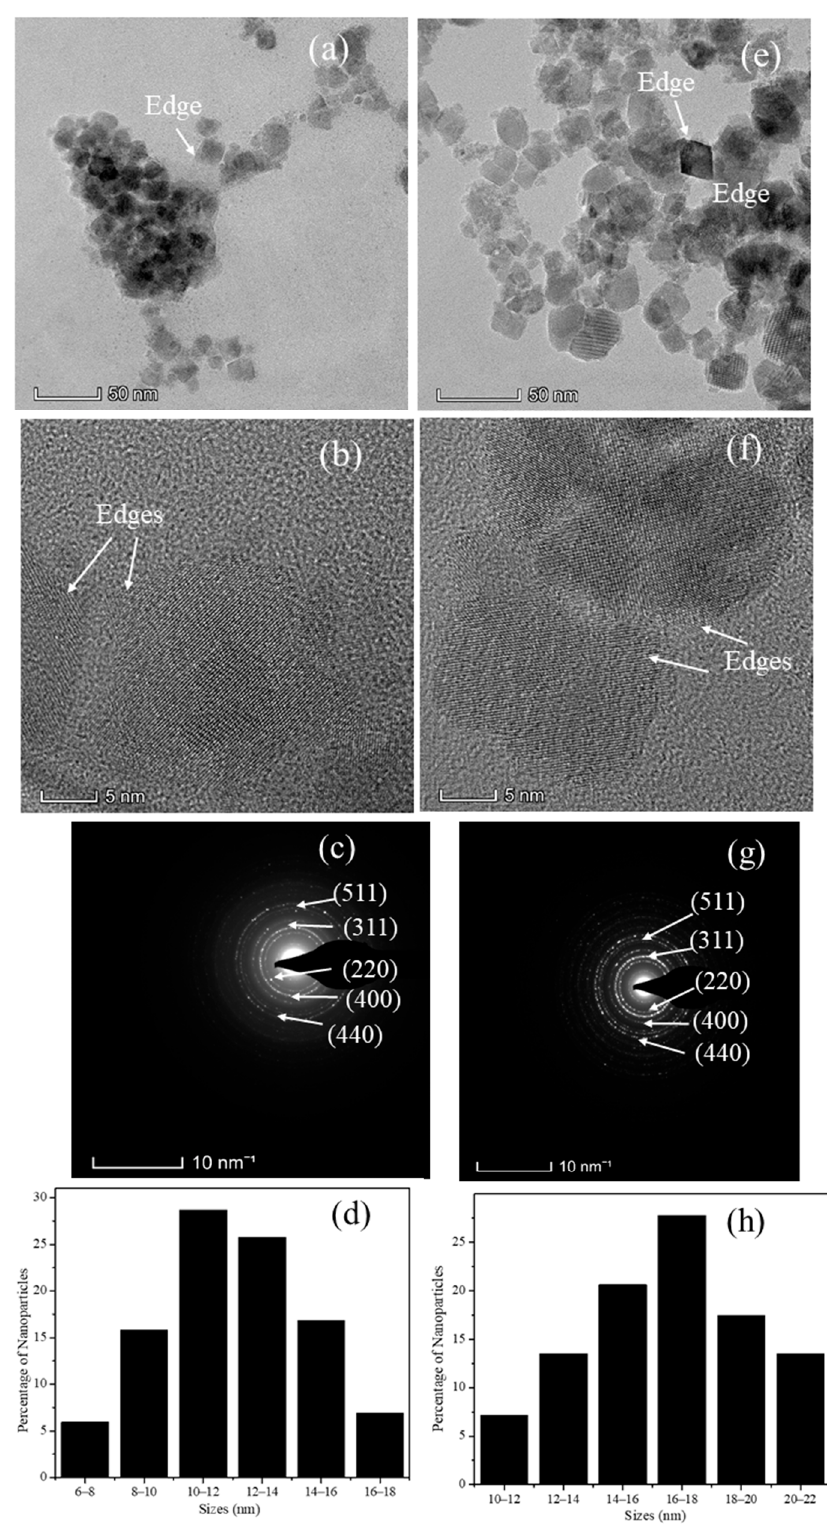
Figure 2. TEM bright field images, HRTEM, selected area electron diffraction patterns, and size distribution of ( a – d ) CoFe 2 O 4 and ( e – h ) Co 0.2 Mn 0.8 Fe 2 O 4